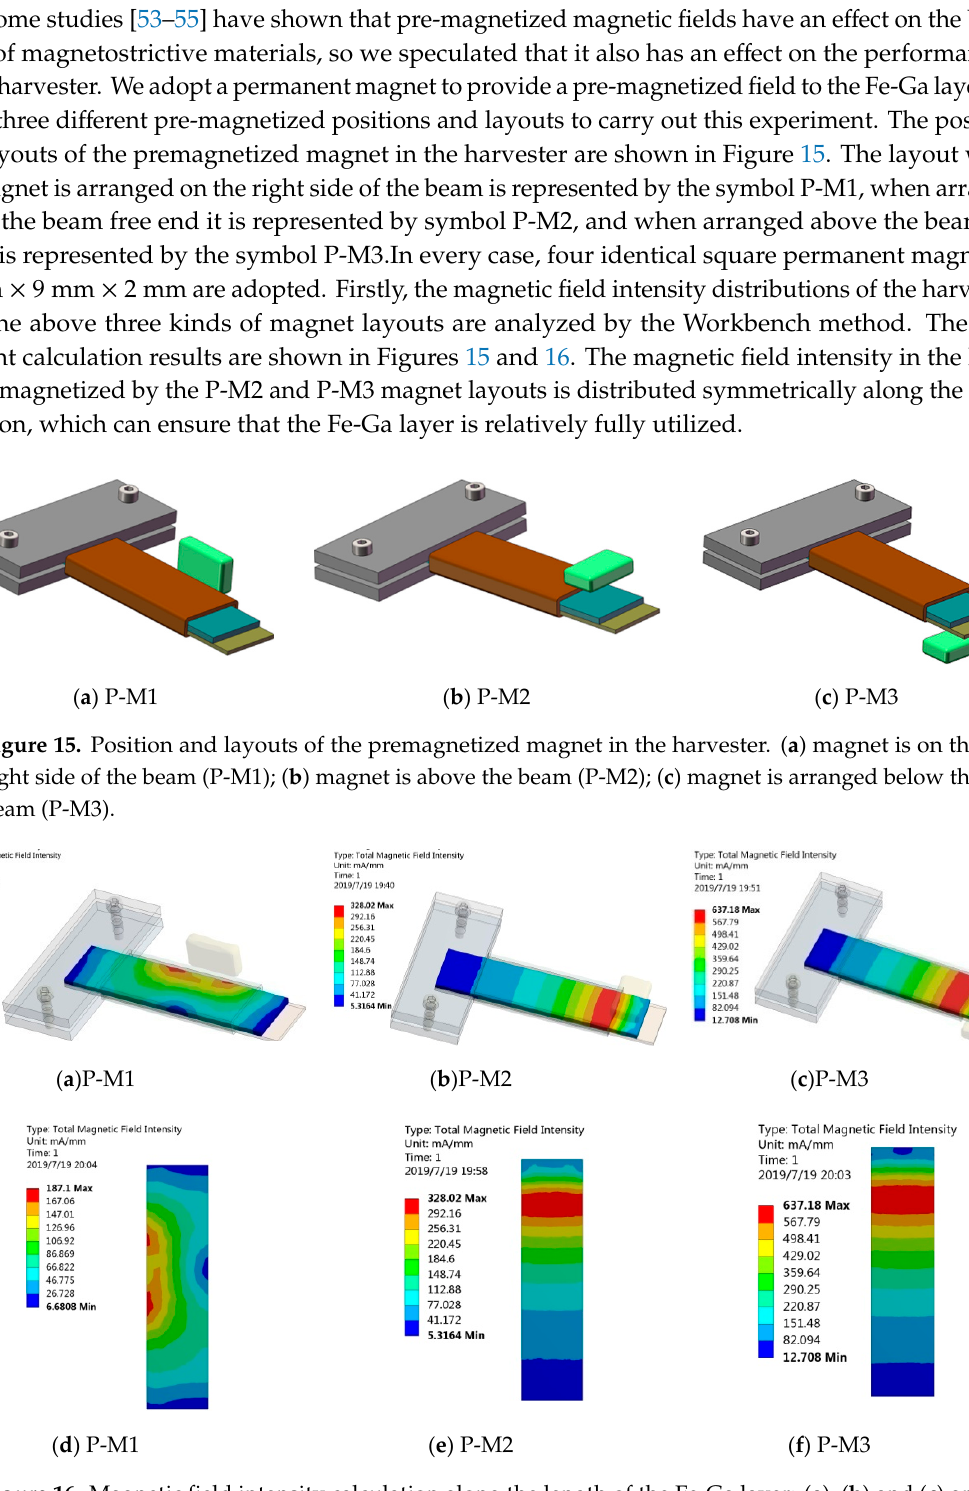
Figure 16. Magnetic field intensity calculation along the length of the Fe-Ga layer: ( a ), ( b ) and ( c ) are 3-D distribution; ( d ), ( e ) and ( f ) are 2-D distribution.